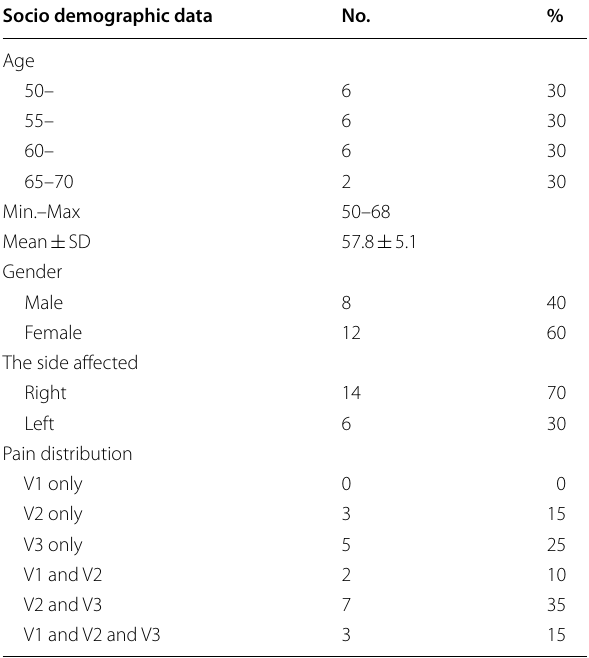
Table 1 Characteristics of 20 patients with TN who underwent microvascular decompression